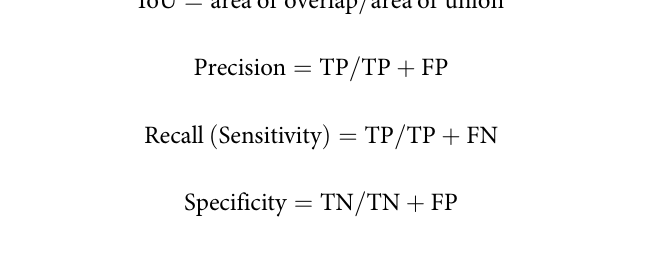
Table 1. Multi-class image classification performances of CNN algorithms on the test sets compared with the average performance of clinicians; ‘oral and maxillofa- cial surgeons’ vs. ‘GPs’.